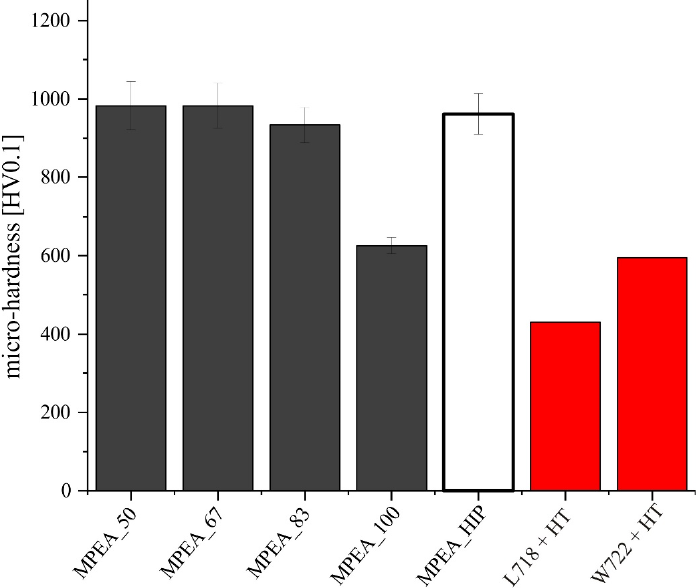
Figure 11. Average micro-hardness of the CrFeNiTi MPEA fabricated via PBF-LB (steady-state region) at varying VED and via solid-state sintering in an HIP process. Comparison to the well-established alloys L718 and W722 after their standard heat treatment [13,15,31].